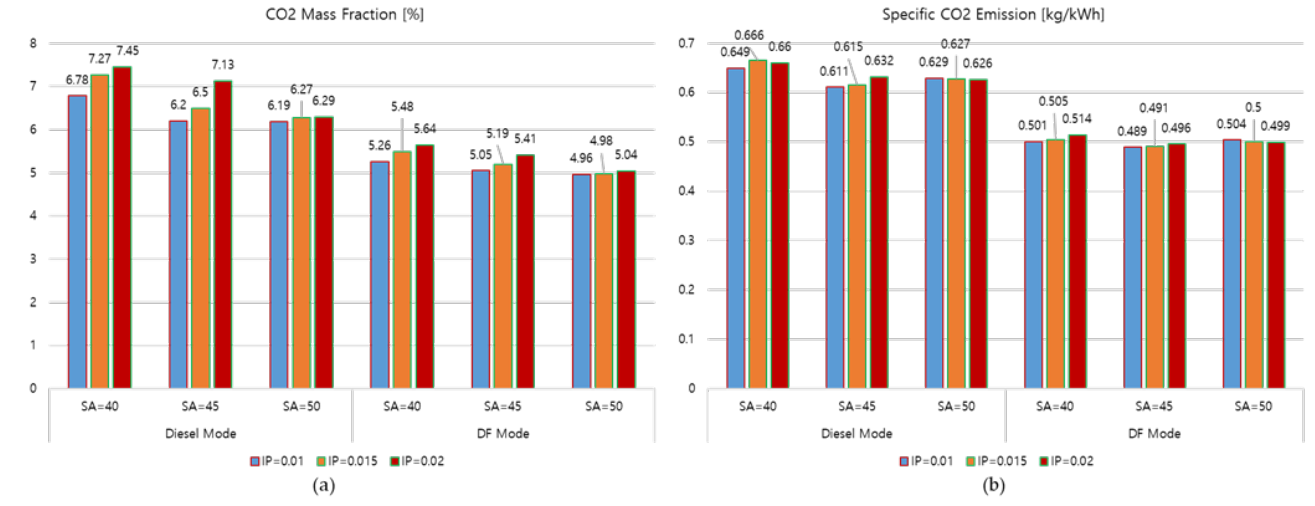
Figure 16. CO 2 emissions in all simulation cases: ( a ) CO 2 mass fractions, ( b ) specific CO 2 emissions.